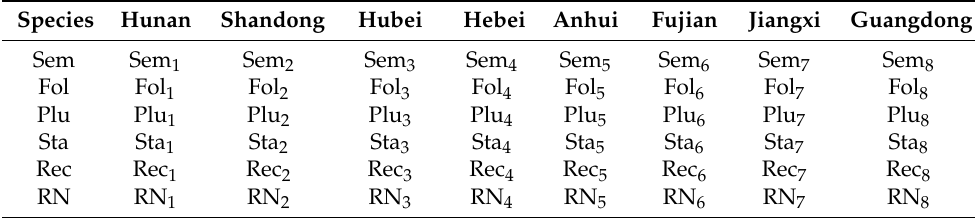
Table 2. The collection sites of the tested samples. Species Hunan Shandong